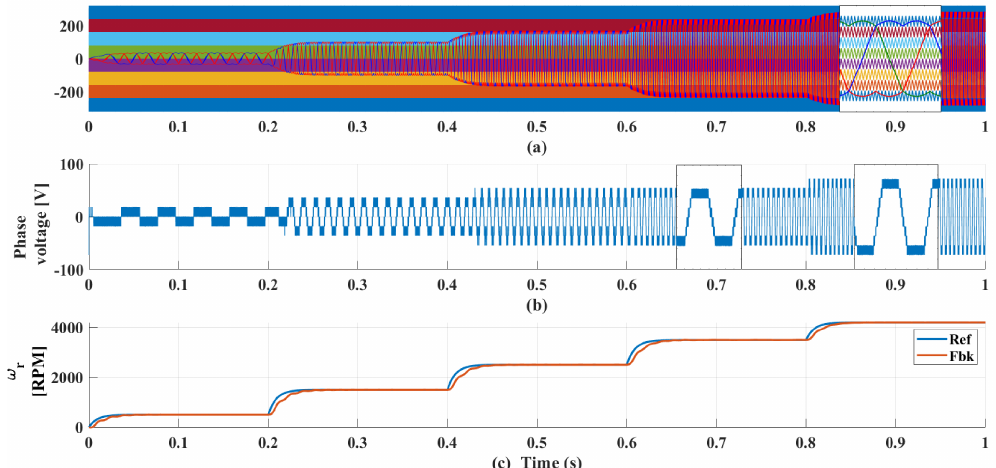
Figure 10. Simulation result obtained by using the 9-level inverter: ( a ) Eight carrier waveforms and modulating waveforms. ( b ) Phase voltage. ( c ) Speed reference (Ref) and speed feedback